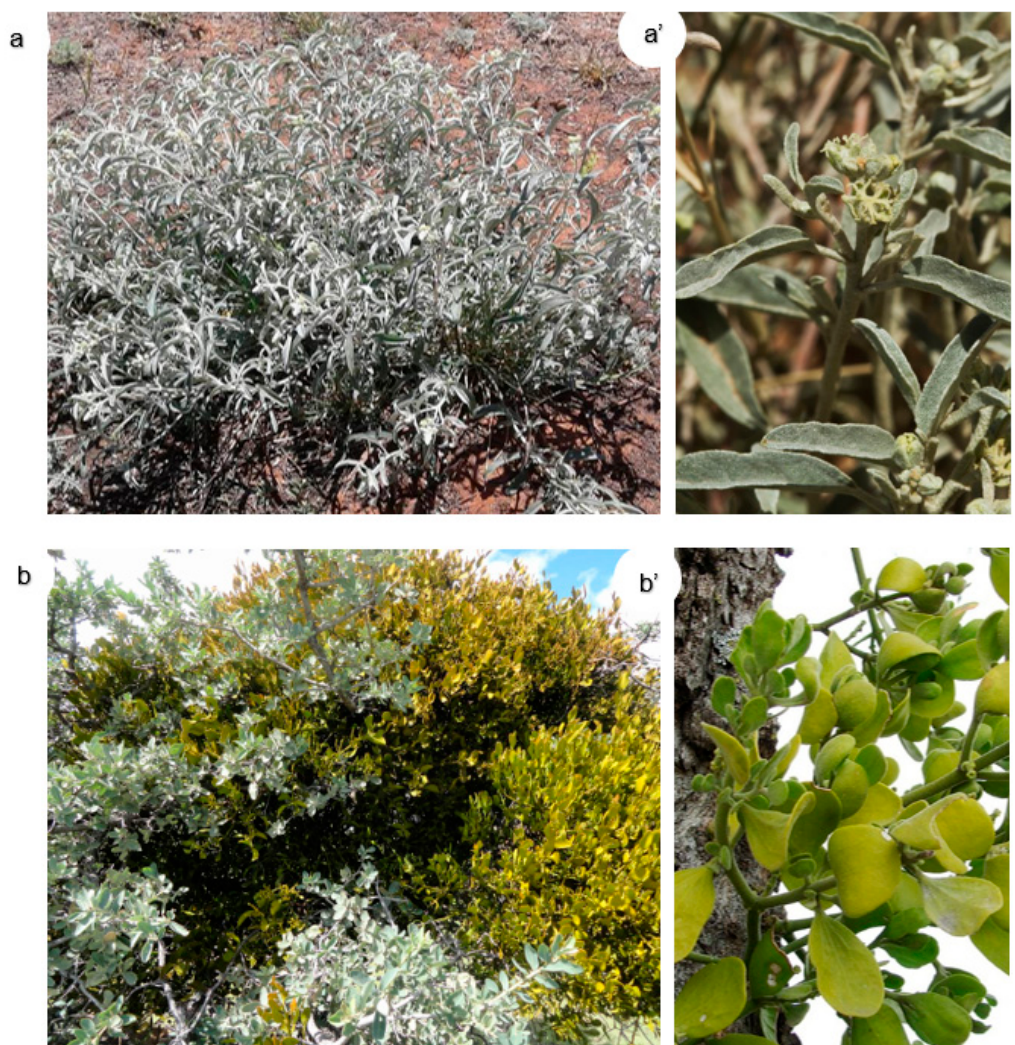
Figure 3. Studied plants: ( a ) and ( a’ ) Croton dioicus; ( b ) and ( b’ ) Phoradendron villosum.